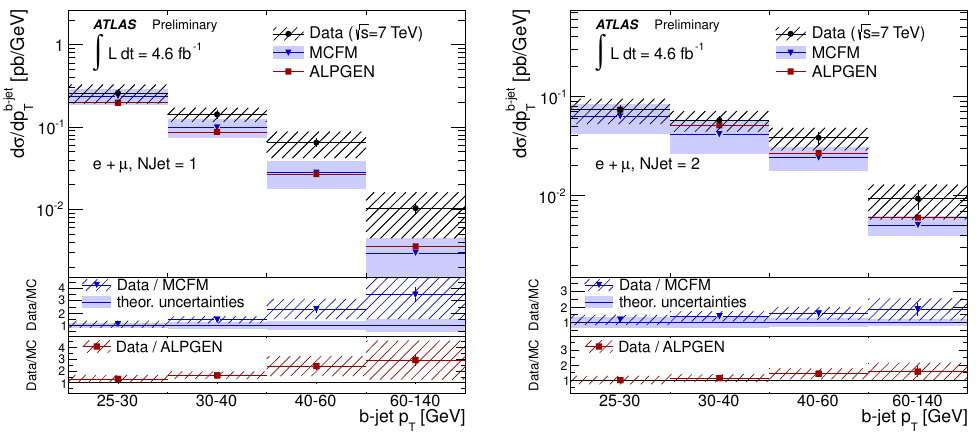
Figure 5. Measured di ff erential W + b-jet cross sections with the statistical plus systematic uncertainty as a function of the b-jet p T in the 1-jet (left) and 2-jet (right) samples, obtained by combining the muon and electron channel results [19]. The measurements are compared to the MCFM [20] and ALPGEN / HERWIG [21]